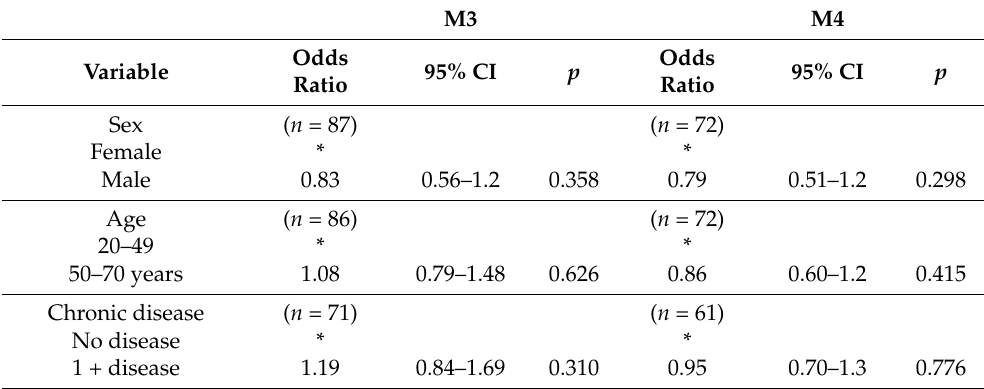
Table 3. Regression on log-transformed SARS-CoV-2 IgG (anti-RBD/S) titers at the M3 (25–70 days after 2nd dose) and M4(150–210 days after 2nd dose) for full-vaccinated individuals. M3 M4 Odds Odds Variable 95% CI p 95% CI p Ratio Ratio Sex ( n = 87) ( n = 72) Female * * Male 0.83 * * ( n = 71) ( n = 61) * * 1.19